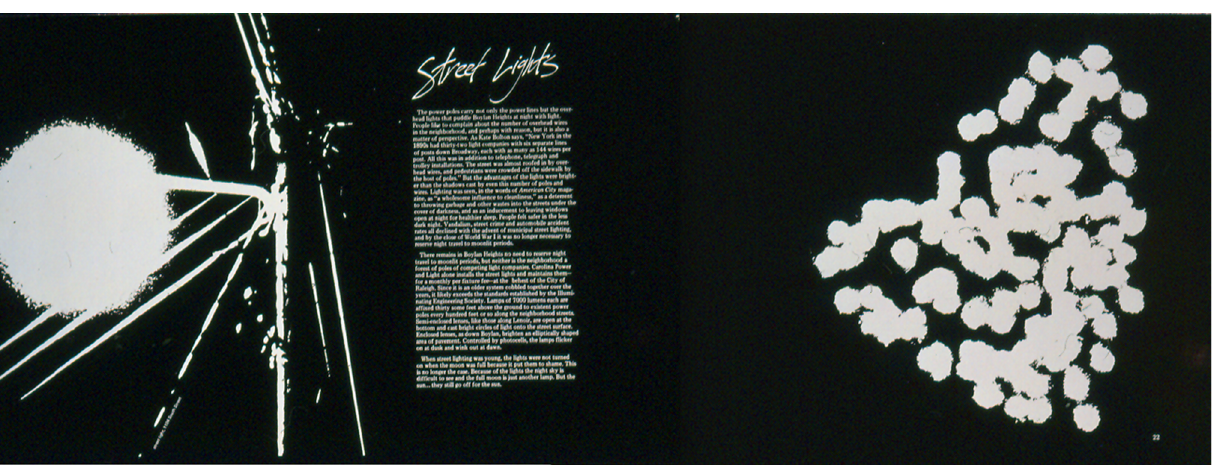
Figure 9. Street Lights, by Carter Crawford ([14]; used with